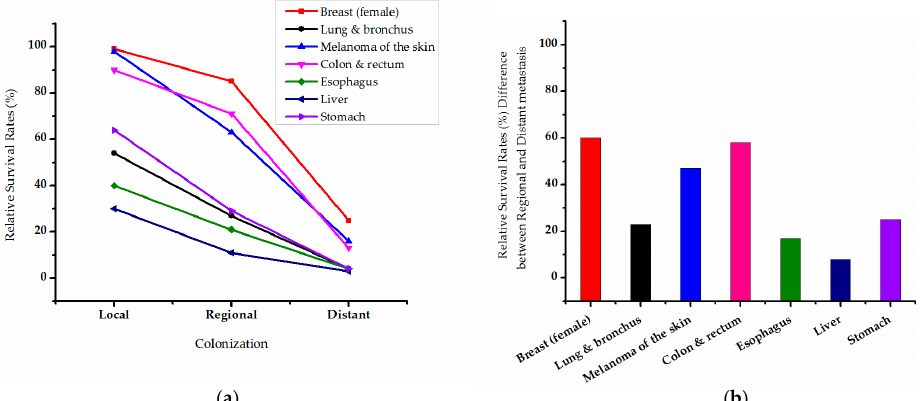
Figure 2. ( a ) Five-year Relative Survival Rates* (%) by Stage at Diagnosis, US, 2004–2010. Local: an invasive malignant tumor confined to primary organ. Regional: a malignant tumor that has extended into surrounding organs or tissues and regional lymph nodes. Distan t : a malignant tumor that has spread to parts of the body remote from the primary cancer, or via the lymphatic system to distant lymph nodes; ( b ) The difference in relative survival rates between Regional and Distant metastases, and Value (%) = Regional–Distant. Rates* are adjusted for normal life expectancy and are based on cases diagnosed in the SEER 18 areas from 2004 to 2010, all followed through 2011, and the data are from the American Cancer Society, Inc., Surveillance Research, 2015.